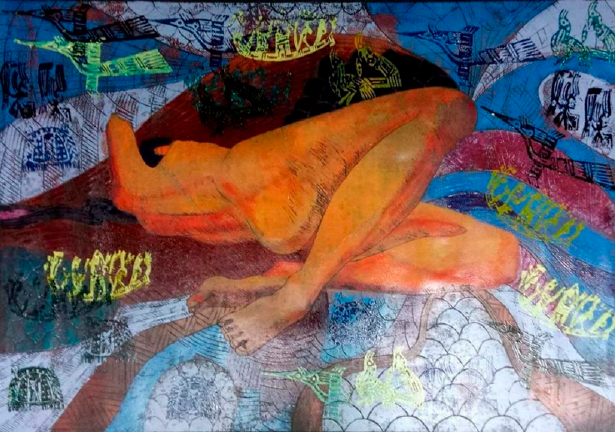
Figure A27. Cau chuyen tram trung— Dam Van Tho painted in 2017. The image was sourced from Thanh Nien Newspaper (Nguyen 2017b).